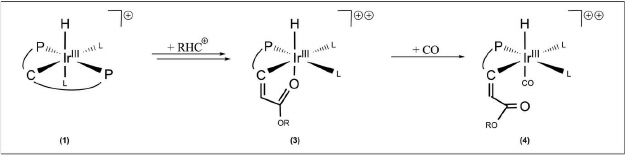
Figure 3 The sequence of ligand replacements and reorganizations accompanying the transformation of 2 into 3 and then 4